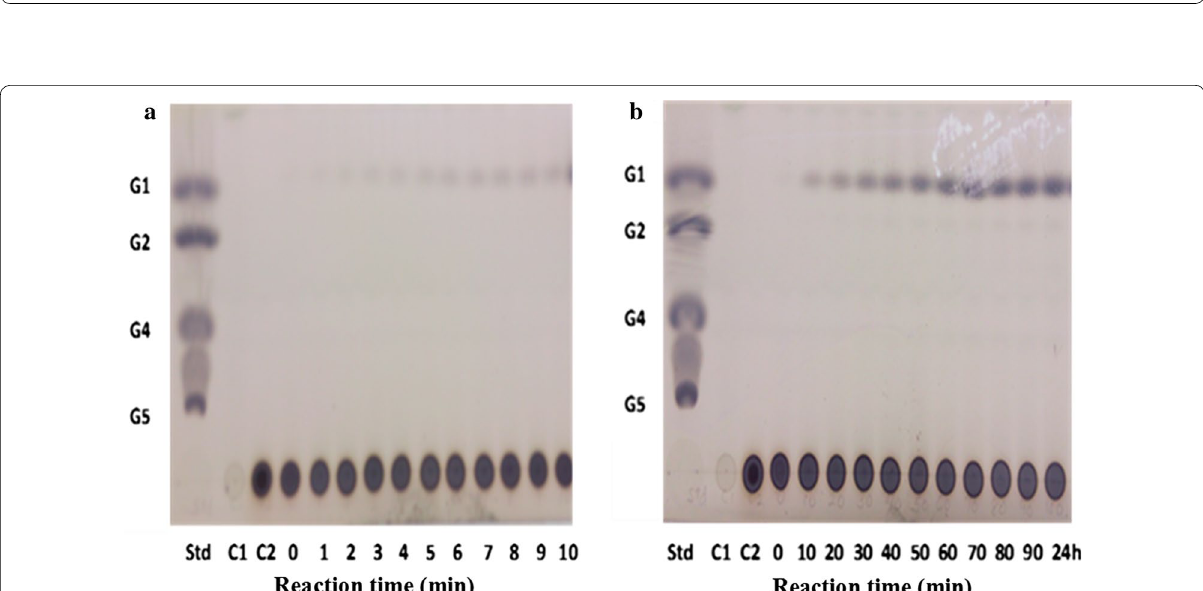
Fig. 2 Thin-layer chromatograms of hydrolyzates. Plates were developed twice with n -butanol: acetic acid: water (2:1:1, v/v/v). The plates were briefly submerged in methanol containing 5% (v/v) sulfuric acid and 0.3% α-naphthol. Standard (Std): glucose (G1), maltose (G2), maltotetraose (G4), and maltopentaose (G5), substrate control (C1), enzyme control (C2), reaction time: 0–90 min and 24